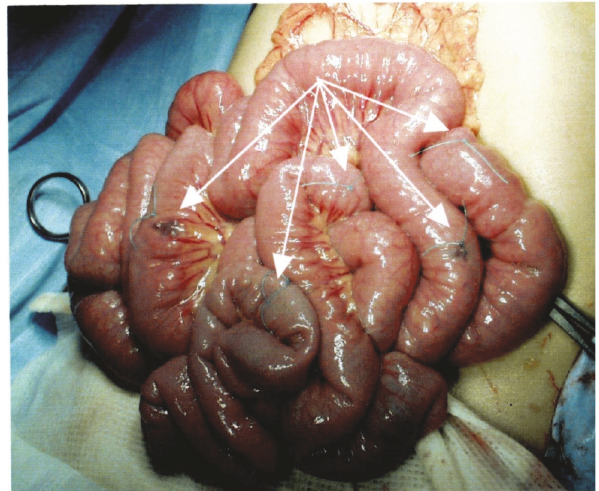
Figure 1: Demonstration of the first operation at 5 years of age: multiple venous malformations on the small intestine (marked by the arrows) were